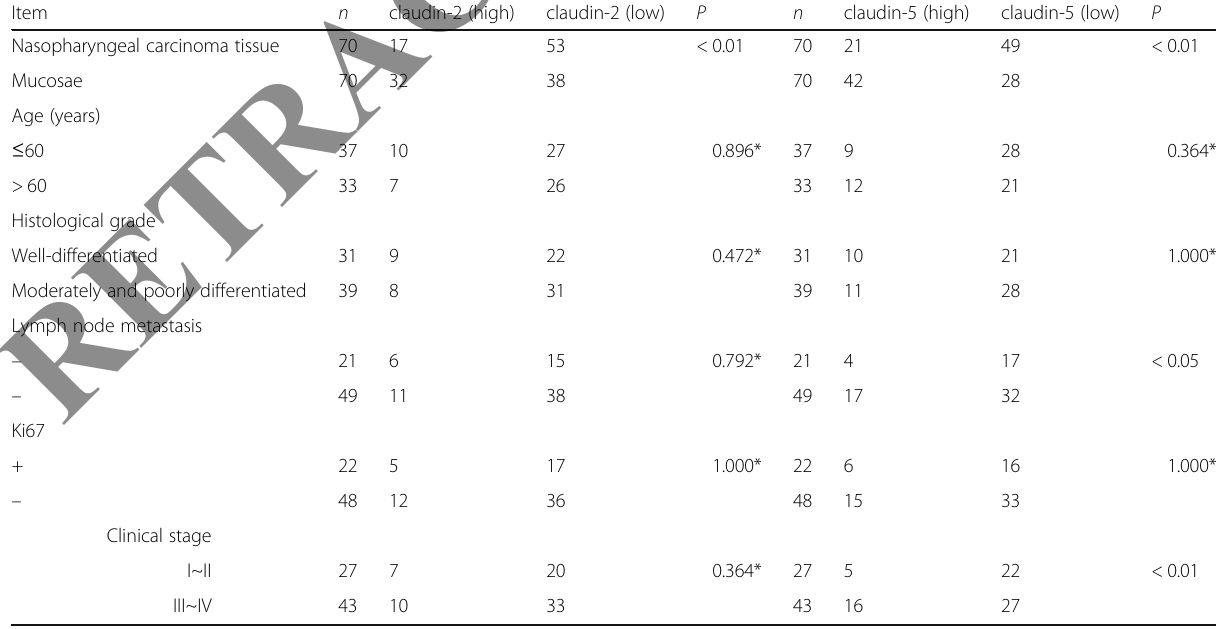
Table 1 Expression of claudin-2 and claudin-5 and the clinicopathological characteristics in nasopharyngeal carcinoma patients Item